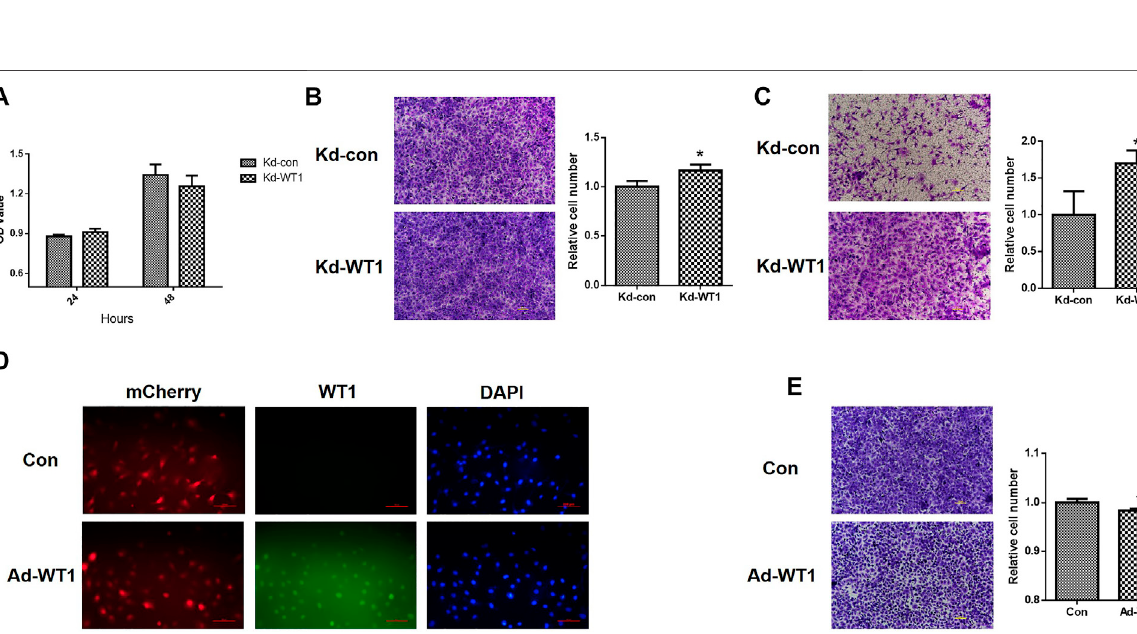
Frontiers in Bioengineering and Biotechnology |